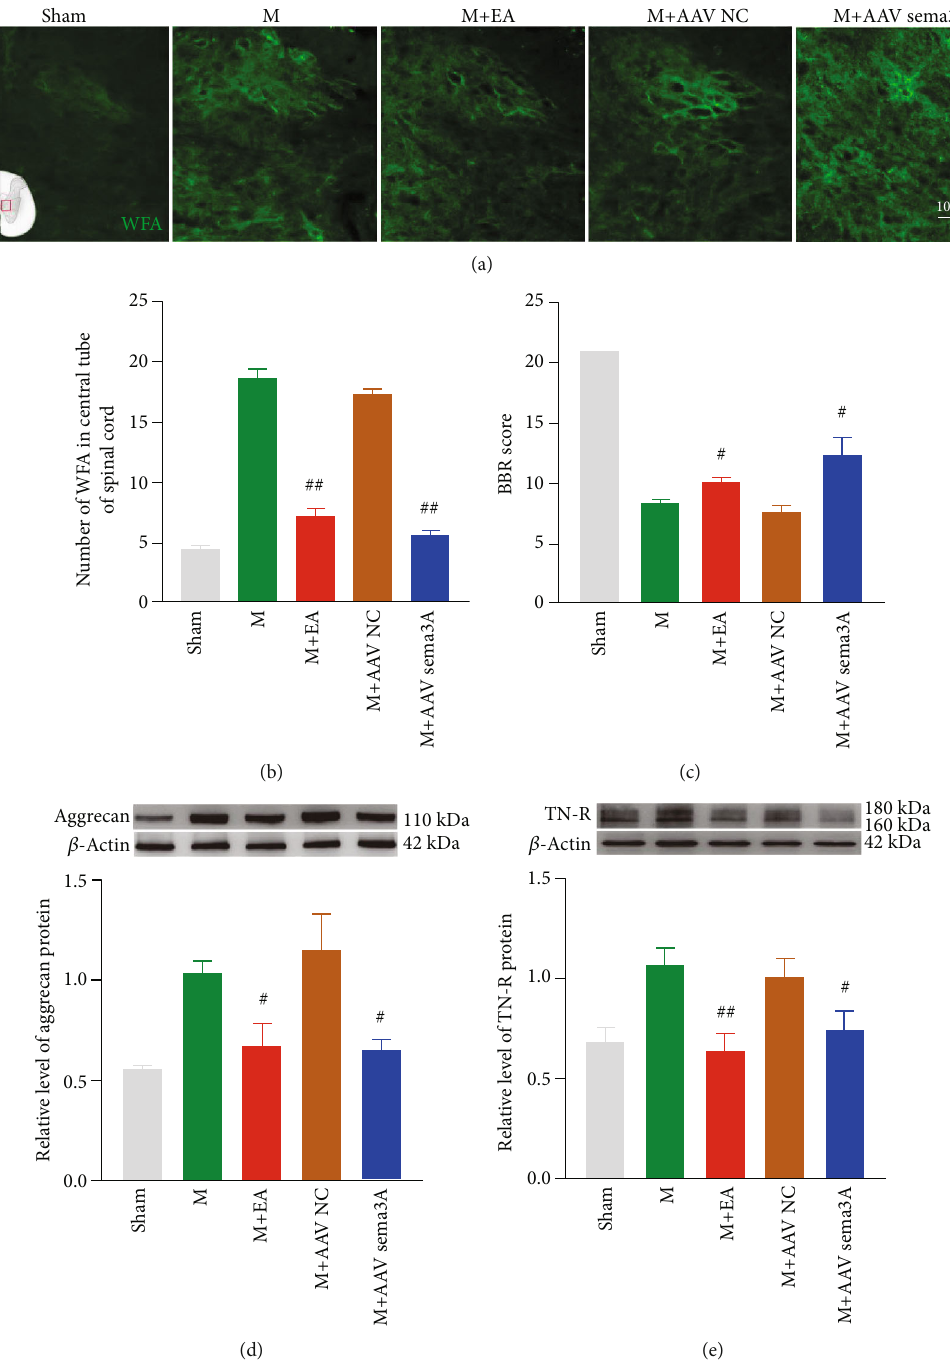
Figure 8: The expressions of WFA and TN-R and aggrecan in the spinal cord were downregulated by EA and Sema3A knocking. (a) A representative chart of the changes of the WFA expression around the central tube of the spinal cord in the sham group, 14 days after SCI, M +EA group, M + AAV Sema3A group, and M + AAV NC group, was shown by immuno fl uorescence. (b) Quanti fi cation of the immuno fl uorescence data in panel (a), n = 3 . (c) The motor function score of each group at day 14. (d, e) The representative band and statistics of aggrecan and TN-R in the spinal cord, n = 5 , compared with the M group, # P < 0 : 05 , ## P < 0 : 01 . All data are presented as the mean ± SEM